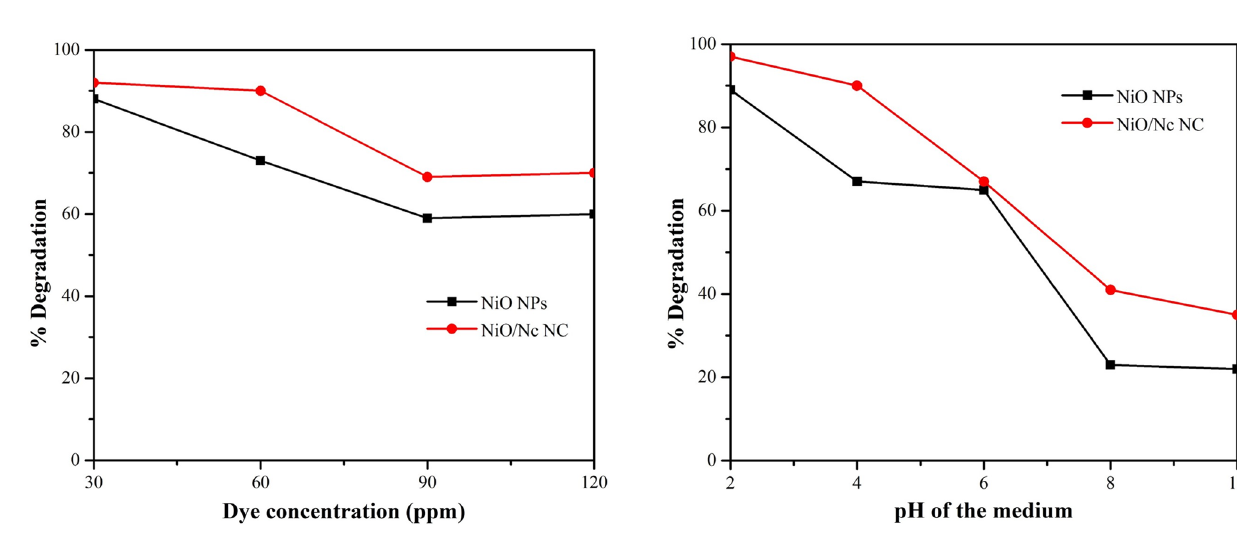
Fig. 10 %degradation of OII dye photodegraded by NiO NPs and NiO/Nc NC at various initial concentration of O II dye